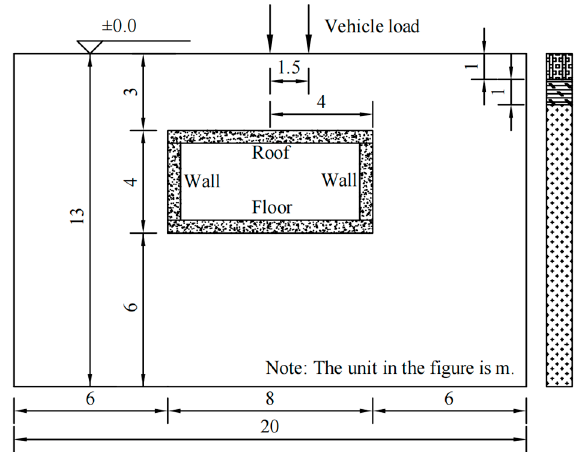
Figure 9. Project section.